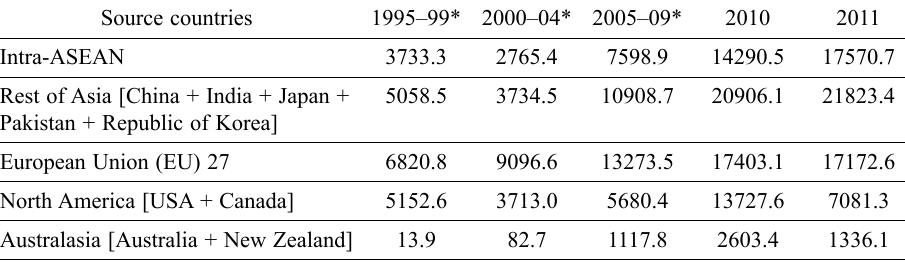
Table 1. Flows of inward FDI to ASEAN by ASEAN’s dialogue